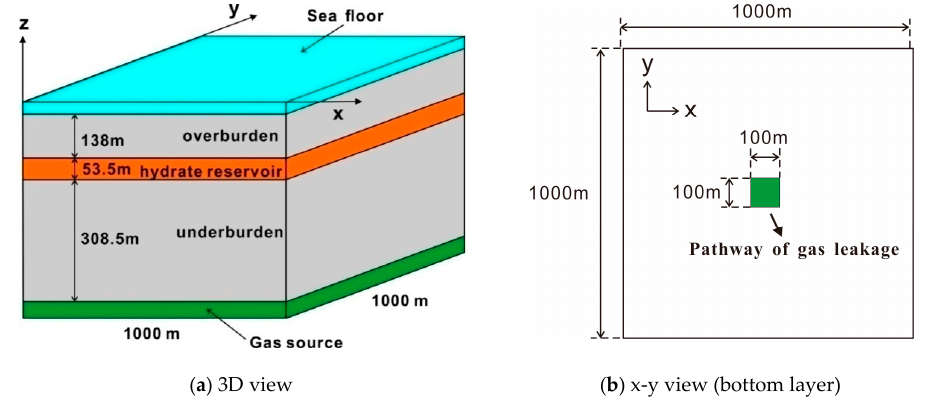
Figure 1. The geometry of the simulation domain.